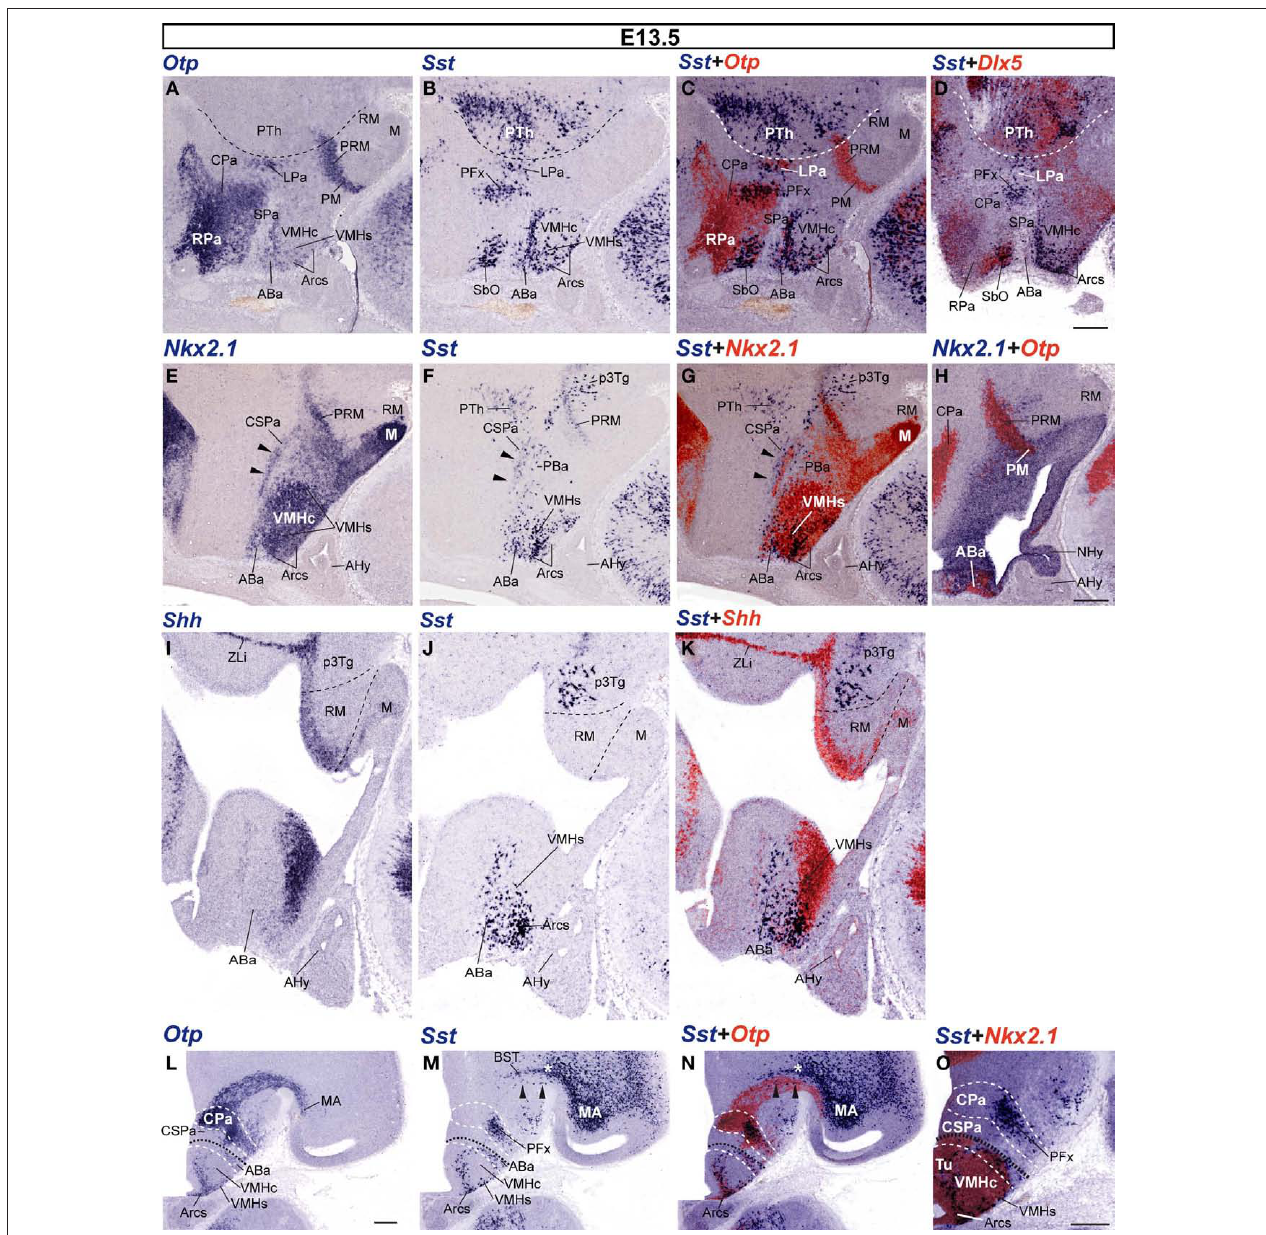
area, next to the floor plate. (L–N) Correlation of Otp and Sst signals in adjacent transversal sections (orthogonal to the alar–basal boundary, marked by the black dashed line; white dashed lines indicate the main alar and basal subdivisions). The telencephalic Otp -positive migration stream of the CPa area – containing isolated Sst cells (black arrowheads in M,N ) – enters the medial amygdalar area (MA), after passing underneath the Sst -positive elements of the subpallial bed nucleus striae terminalis complex (white asterisk; BST). The CPa area itself shows radial stratification of Otp -positive derivatives within its mantle layer (L,N) . At intermediate levels of this domain, superficially migrated Sst cells form an aggregate interpreted as a perifornical population [PFx (M,N) ], though it may contain as well elements destined to reach the entopeduncular nucleus, more superficially (not shown). A higher magnification detail of this area is shown in (O) . Within the basal plate, both Otp and Sst cells are observed at the VMHs and Arcs formations, as well as in the overlying ABa. Corresponding overlap between Nkx2.1 and Sst signals is shown in (O) . Bars = 200